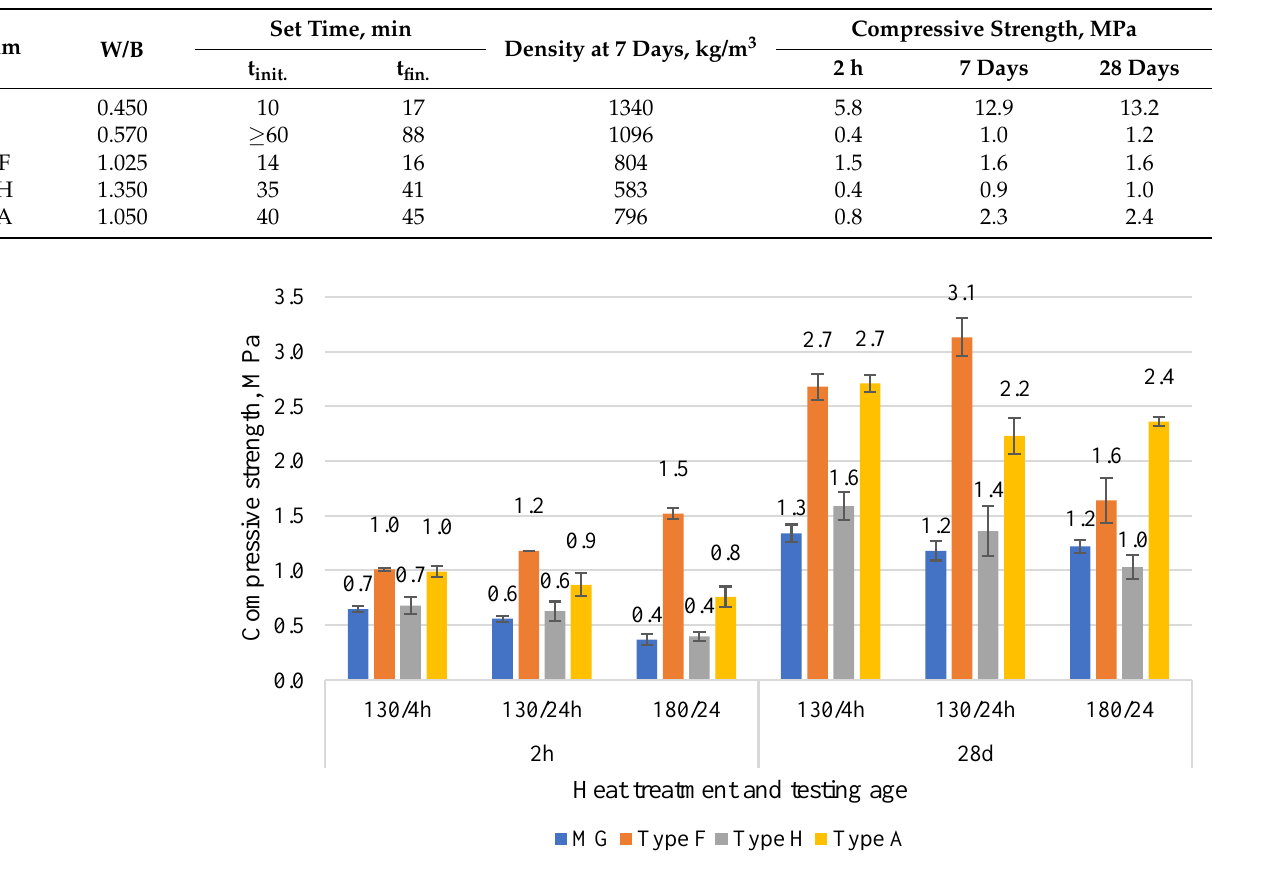
Figure 7. The compressive strength of various CDW gypsum binders was obtained in three different temperature regimes at the age of 2 h and 28 d.